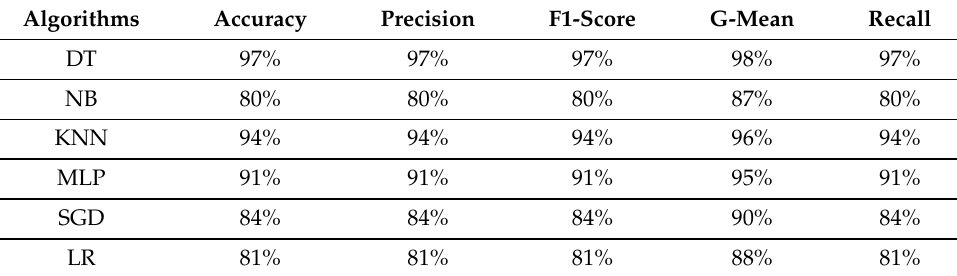
Table 2. Score values of the various measures for each algorithm in the (Udacity) dataset.